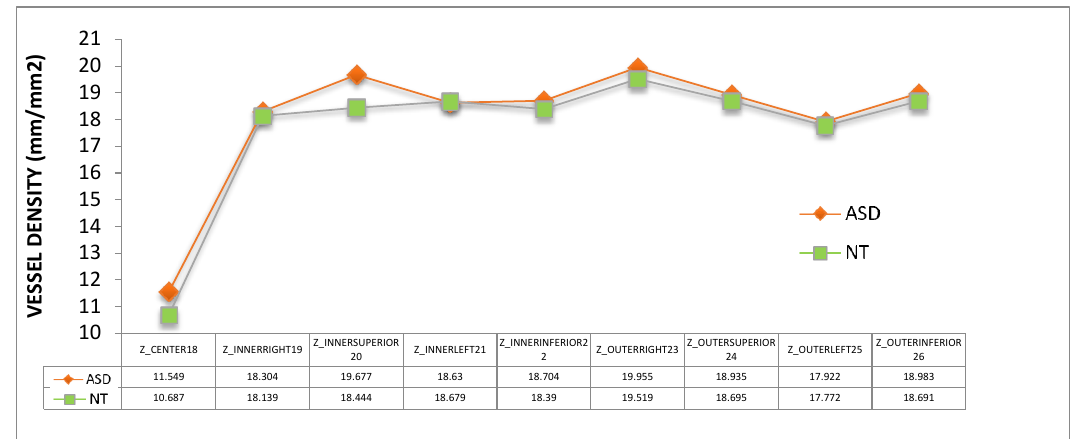
Figure 9. Vessel density of the nine subfields of the macular ETDRS grid. ASD = autism spectrum disorder group; NT = neurotypical group. Mean values were indicated for each group. No significant differences were detected between groups (Mann–Whitney U test). FAZ area (ASD = 0.195 ± 0.59 versus NT = 0.194 ± 0.59 mm 2 ), FAZ perimetry (ASD = 1.759 ± 0.30 versus NT = 1.652 ± 0.61 mm) and FAZ circularity (ASD = 0.778 ± 0.52 versus NT = 0.727 ± 0.12) di ff erences were not found statistically significant between the ASD and NT groups ( p > 0.05, Mann–Whitney U